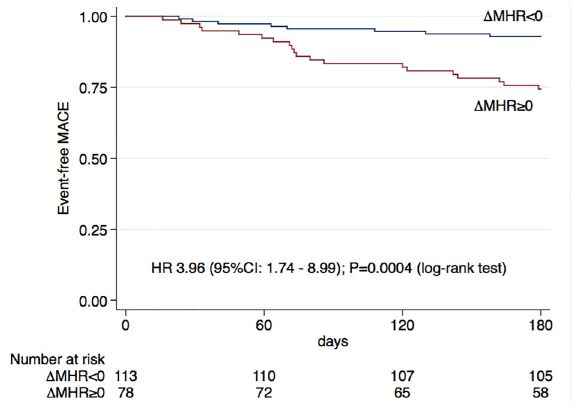
Figure 3. Kaplan-Meier curves showing the proportion of event- free major adverse cardiovascular events (MACE) according to patients ’ D MHR. MHR1: monocyte to high-density lipoprotein cholesterol ratio at hospital admission; MHR2: monocyte to high-density lipoprotein cholesterol ratio at fi rst outpatient evaluation; D MHR: MHR2 – MHR1; HR: hazard ratio; CI: con- fi dence